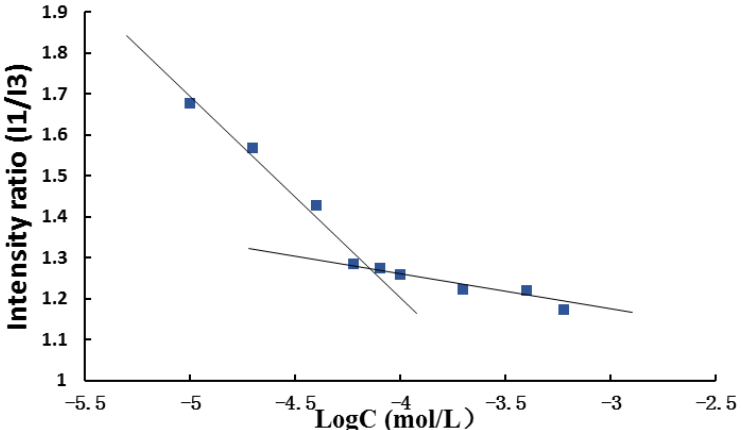
Figure 5. Critical micelle concentration (CMC) measurement using pyrene as fluorescent probe: plots of the intensity ratio ( I 1 / I 3 ) from pyrene emission spectra versus the log of concentration for pH sensitive P123-DTX conjugate ([pyrene] = 1.0 × 10 −7